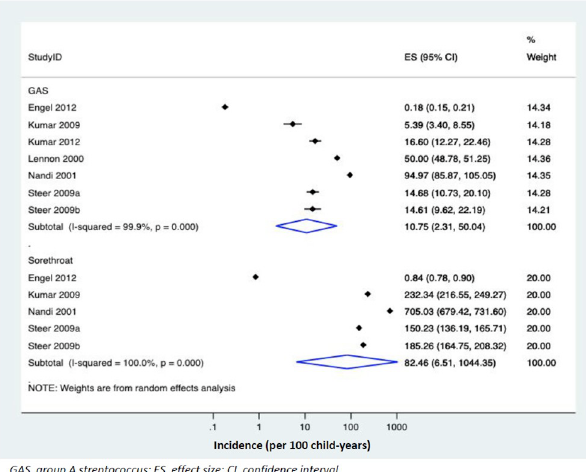
Fig 2. Pooled incidence rates of GAS pharyngitis and sore throat in children at risk of acute rheumatic fever.